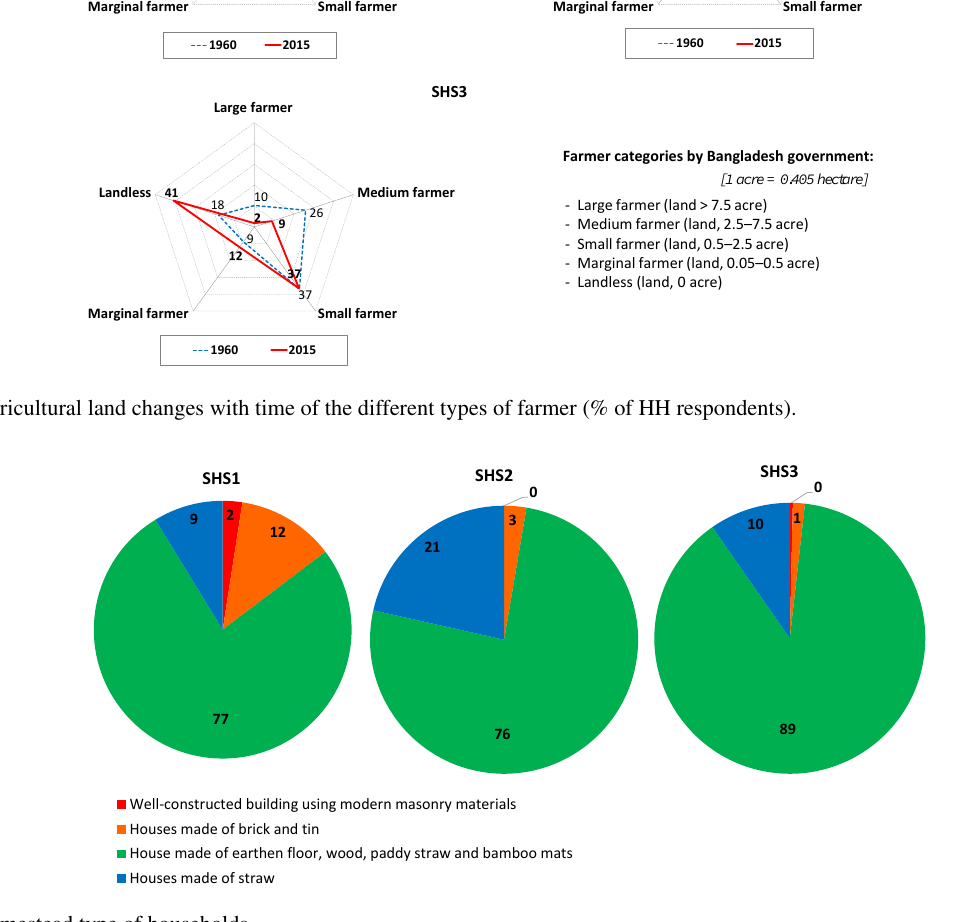
Figure 6. Homestead type of